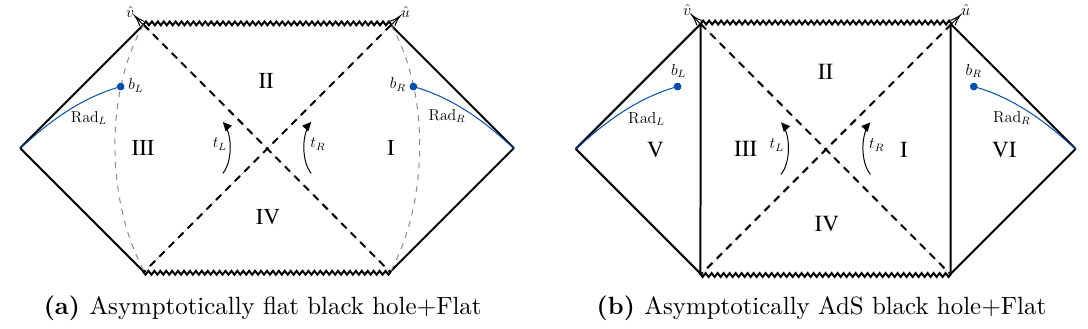
Figure 1. Penrose diagrams of the whole gravitational system ( Left : asymptotically flat black hole with single horizon and singularity. right : asymptotically AdS black hole with single horizon and singularity). Each point on diagrams represents a ( D − 2 )-dimensional sphere. The dotted gray lines in (a) are boundaries of non-gravitational baths which used to collect the Hawking radiation. The blue lines stand for collecting region with boundaries b in a schwarzschild time slice. L ( R )